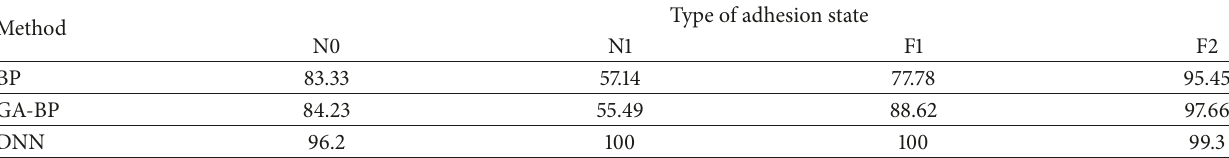
Figure 13: Confusion matrix. Table 3: Test accuracy of the four